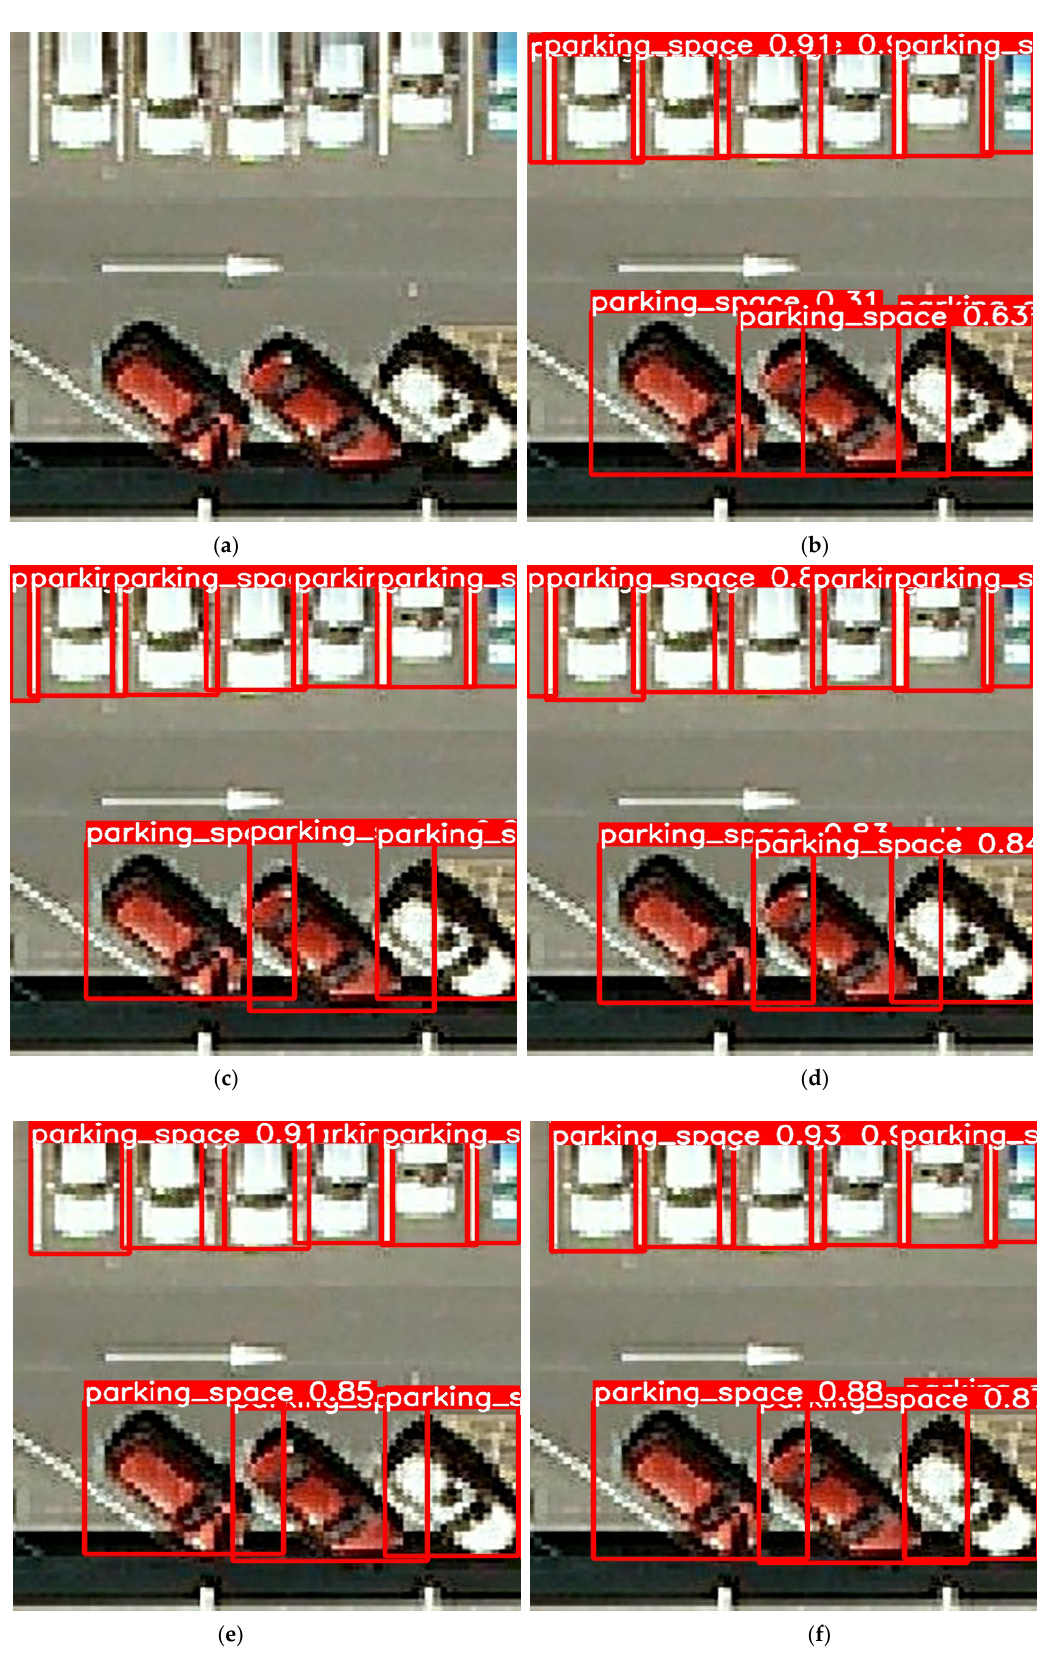
Figure 10. Unobstructed detection in small object scenes: ( a ) detection of the original image; ( b )YOLOv5; ( c ) YOLOv5 with SPPF; ( d ) YOLOv5 with K-means++; ( e ) YOLOv5 with ASFF; and ( f ) ASFF-YOLOv5.